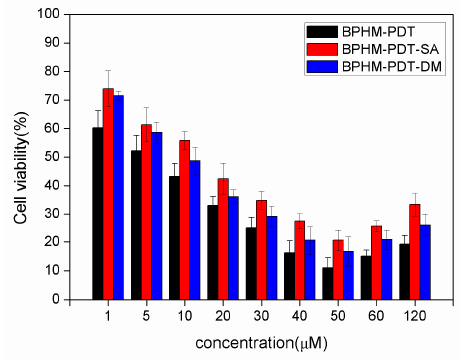
Figure 3. Cell viability of BPHM-PDT, BPHM-PDT-SA, and BPHM-PDT-DM group after PDT treatment 24 h, respectively. BPHM-PDT (black column) stands for the groups treated with BPHM under light (675 nm). BPHM-PDT-SA (red column) stands for the groups treated with BPHM and Sodium azide under light (675 nm). BPHM-PDT-DM (blue column) stands for the groups treated with BPHM and D -mannitol under light (675 nm). All of the groups were cultured with different concentrations of BPHM